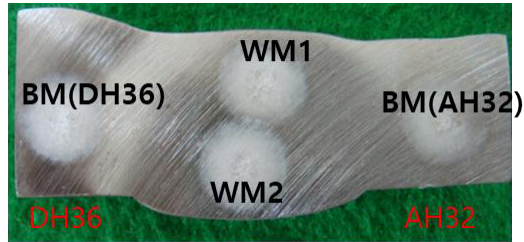
Figure 11. Position of dilution test for welding joint (B1).